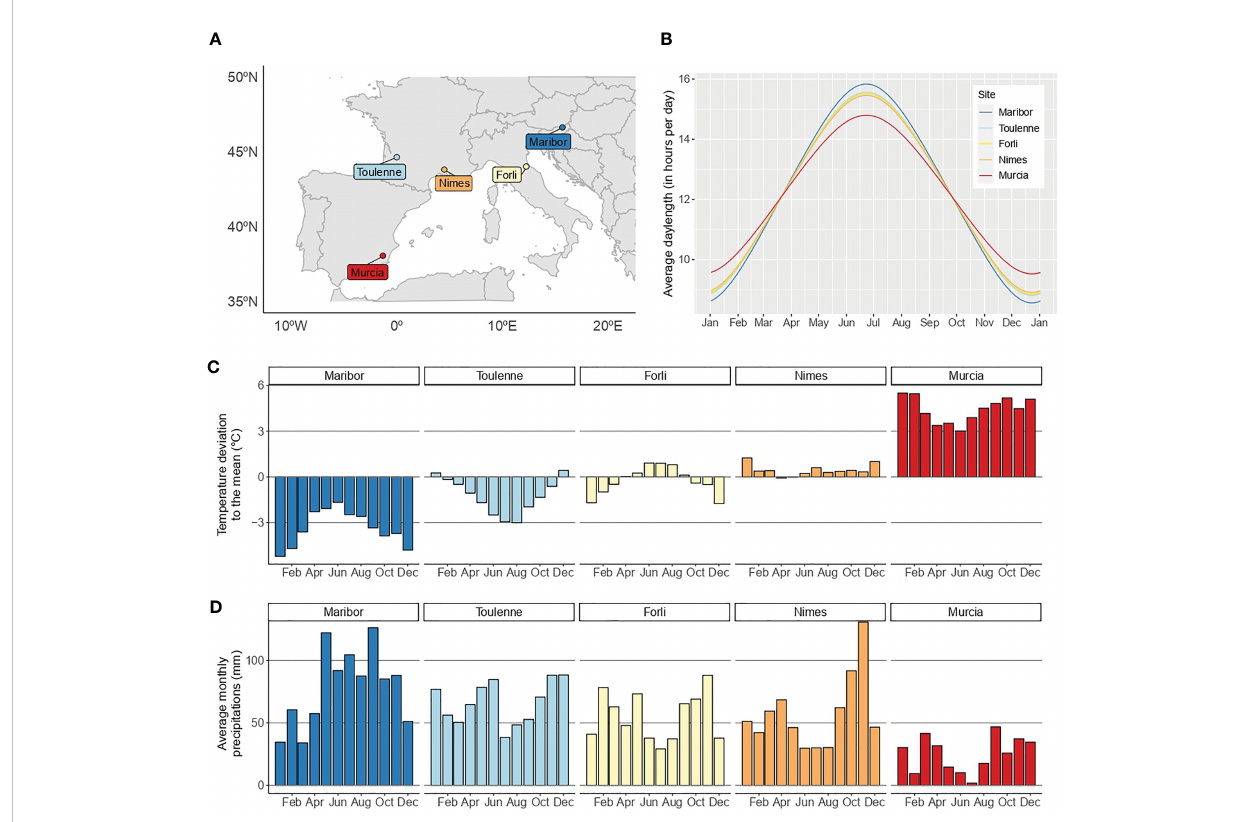
FIGURE 1 Location and environment characterization of the fi ve experimental sites across Europe. (A) , location of the fi ve sites in Europe. (B) , average day length in the fi ve sites. (C) , temperature deviation to the overall monthly mean. (D) , average monthly precipitations in the fi ve sites. In (B – D) , the climatic data used is from 2010 to 2021. A color scale from blue to red was chosen to represent the sites according to the temperature